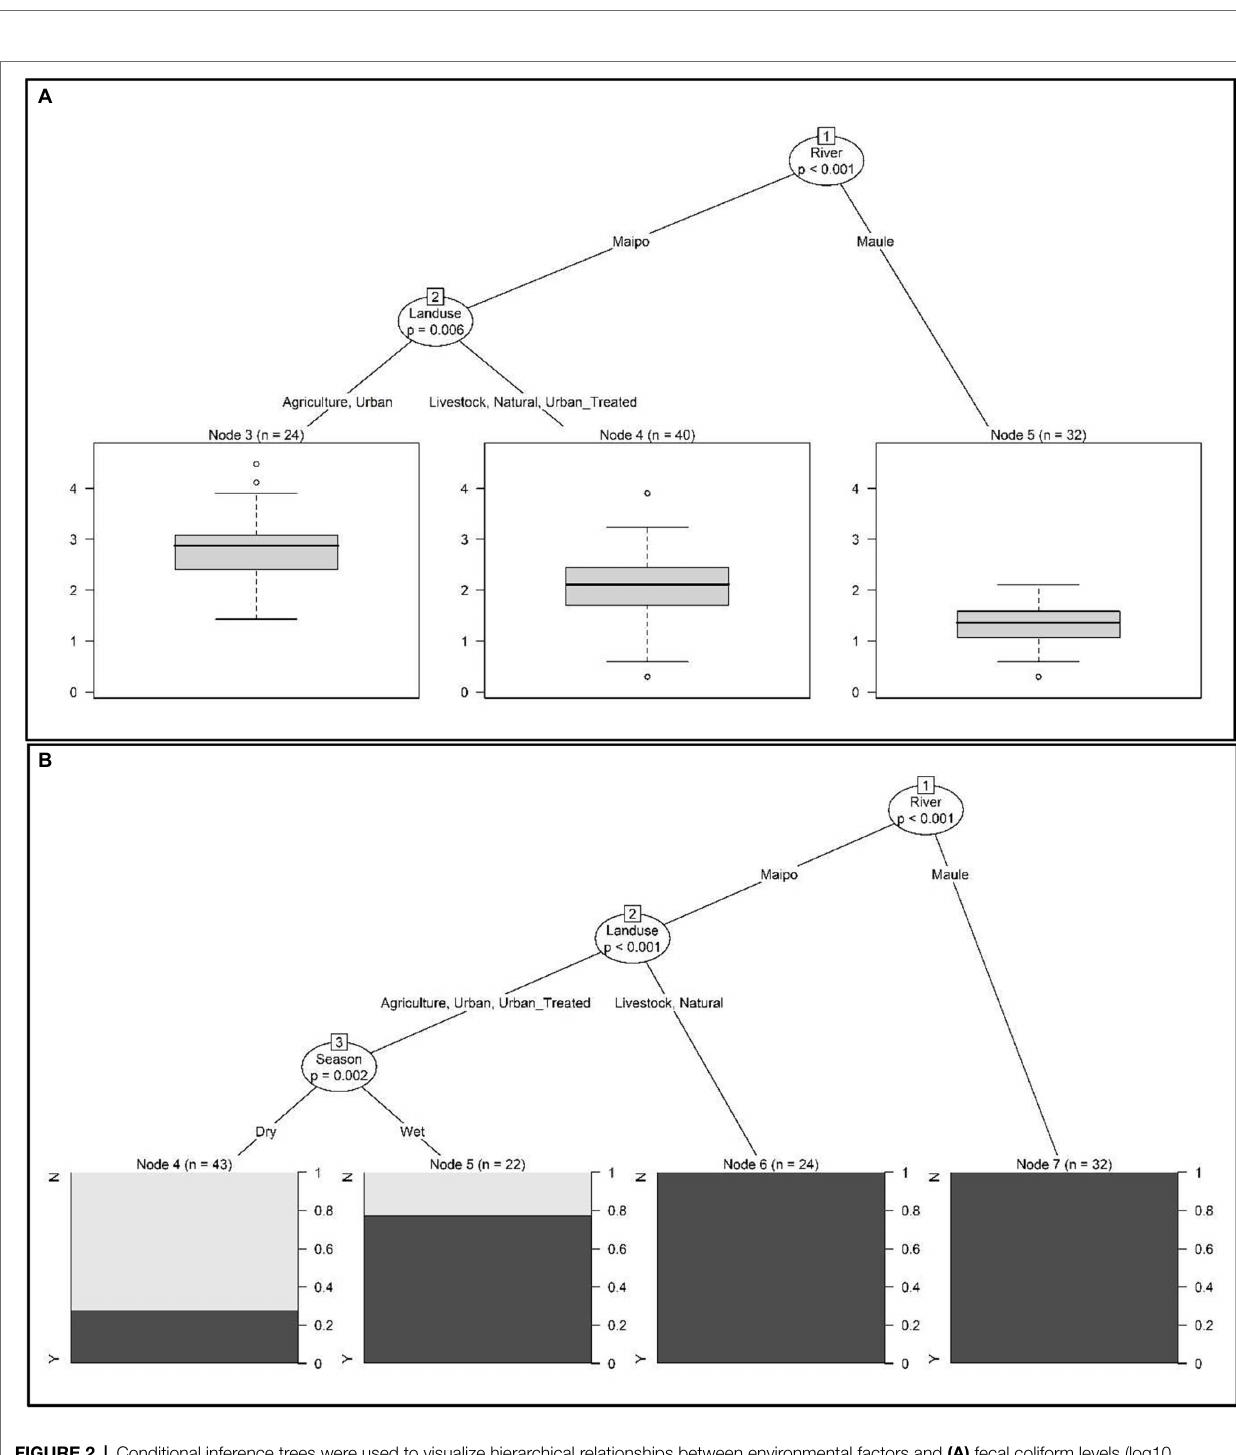
mean = 3.18 oocysts/10 L) compared to the Maule River (range = 0–31 oocysts/10 L; mean = 2 oocysts/10 L; Supplementary Figure S1 ). Higher Giardia spp. counts were also found in the Maipo